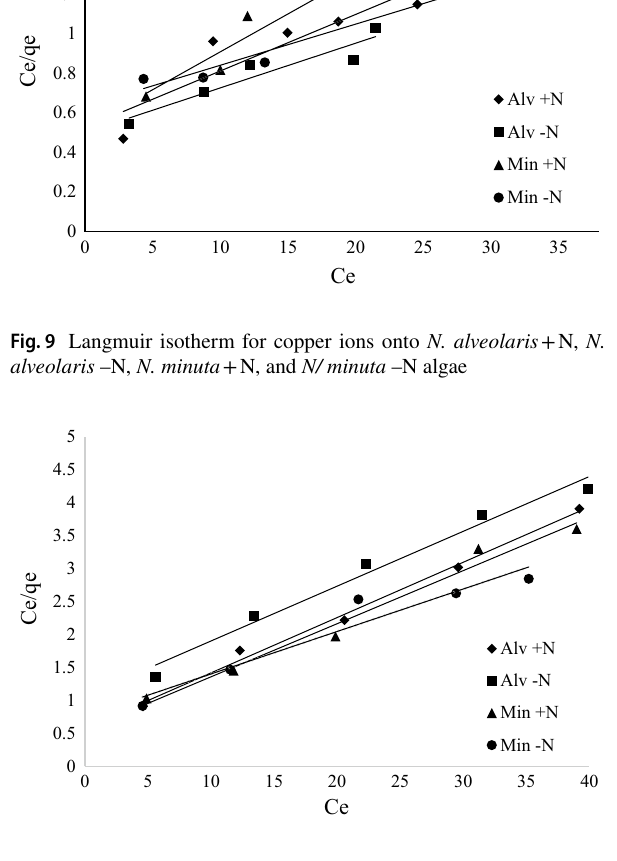
Fig. 10 Langmuir isotherm for nickel ions onto N. alveolaris + N, N. alveolaris